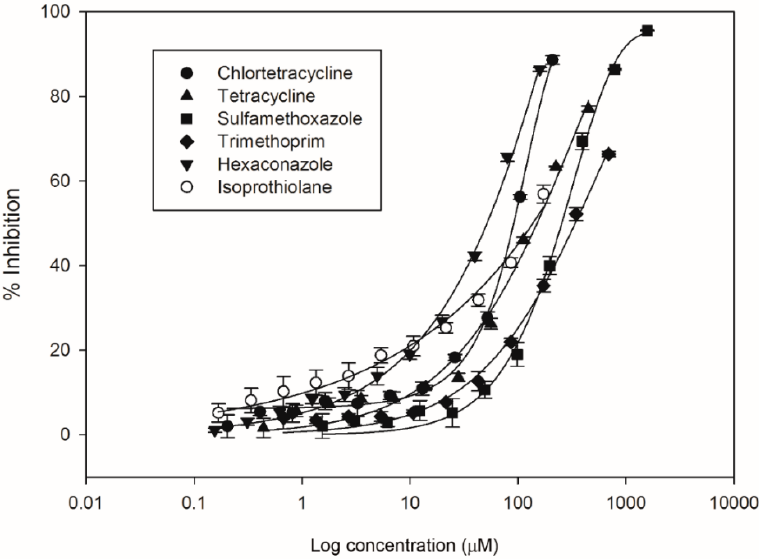
Figure 1. DRCs for the bioluminescent inhibition of A. fischeri for single compounds in Table 1 (the data points are geometric means ± standard deviation [SD] of the experimentally observed data and statistical best-fits (solid lines)).